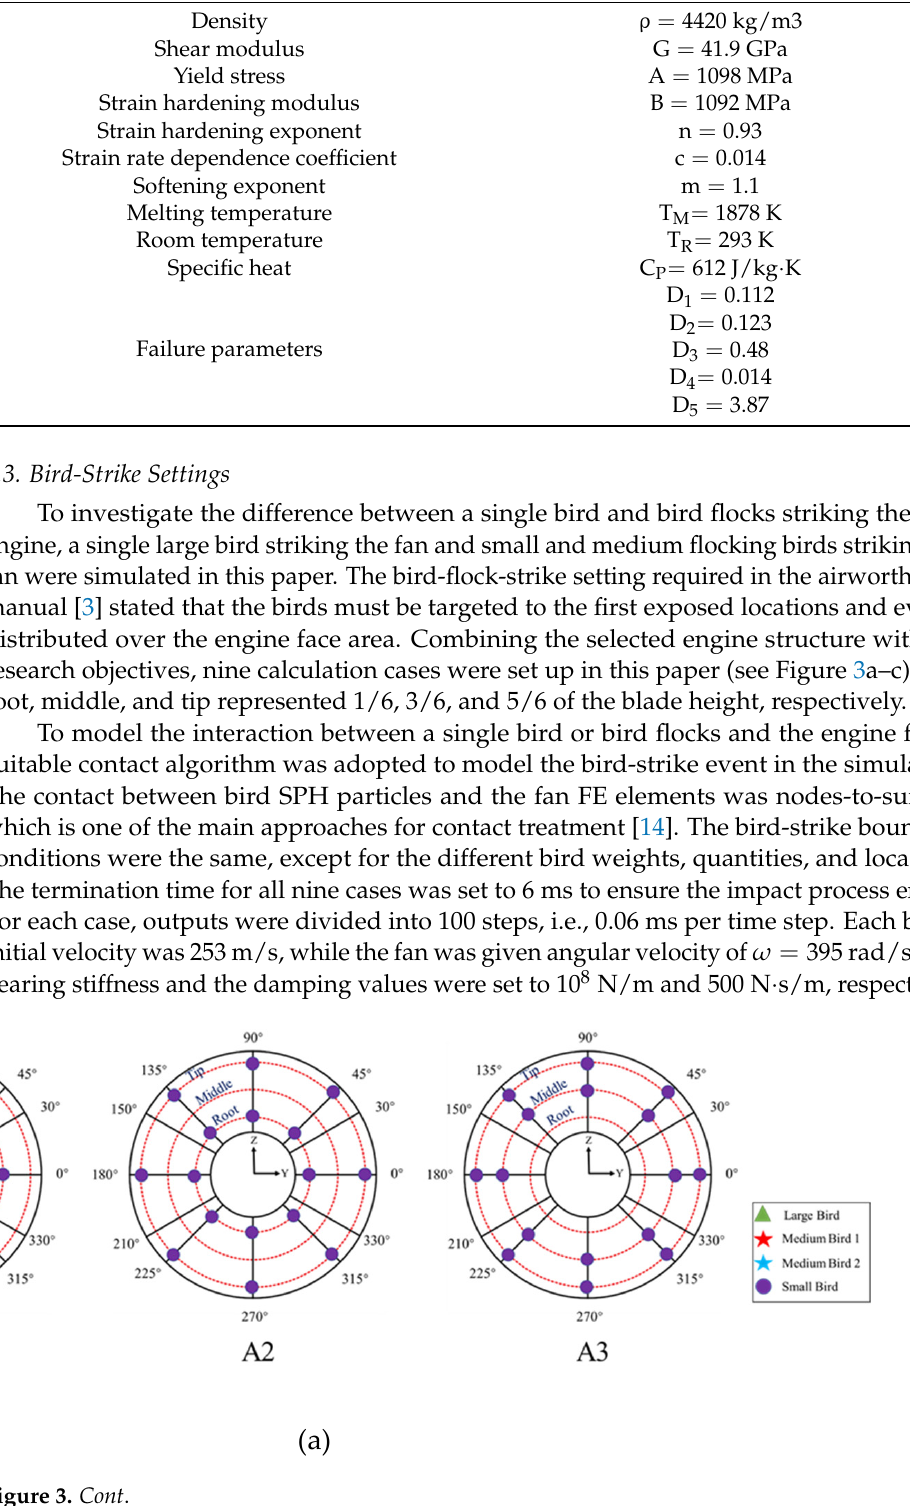
Table 2. Johnson-Cook material parameters for Ti-6Al-4V.